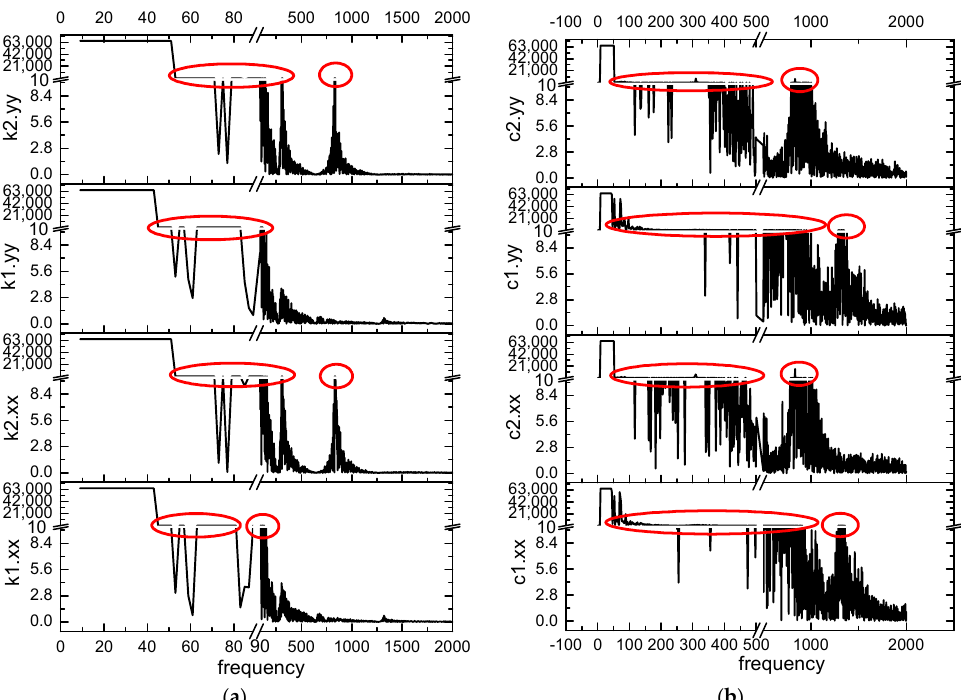
Figure A3. Identified bearing coefficients changing with frequency of g1.4 based on algorithm I considering adjustment point and sensor resolution 1 um: ( a ) obtained main stiffness coefficients in x and y directions; ( b ) obtained main damping coefficients in x and y directions.